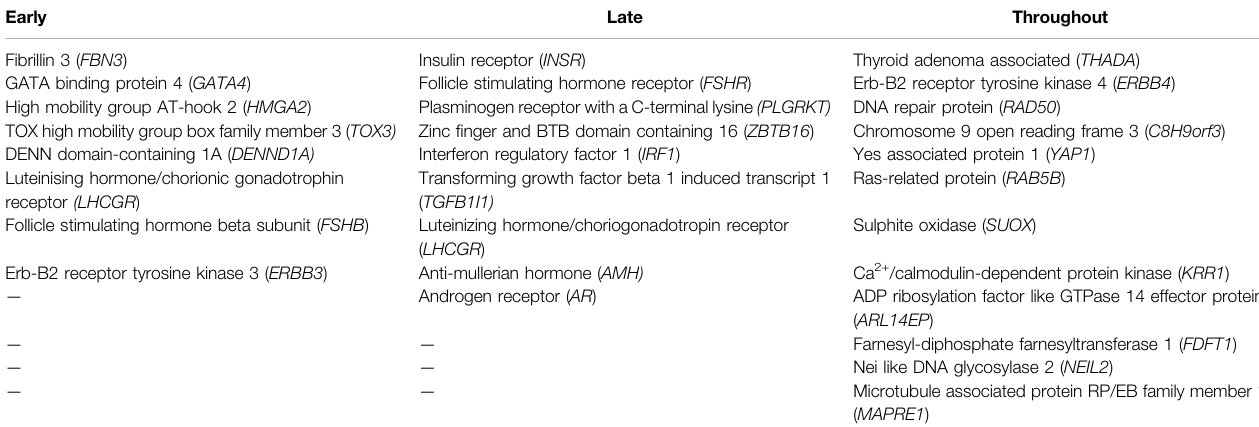
TABLE 1 | The three distinct expression patterns of PCOS candidate genes observed during fetal ovary development according to Hartanti, et al. (2020), Liu, et al. (2020); early, late and throughout gestation. Early Late